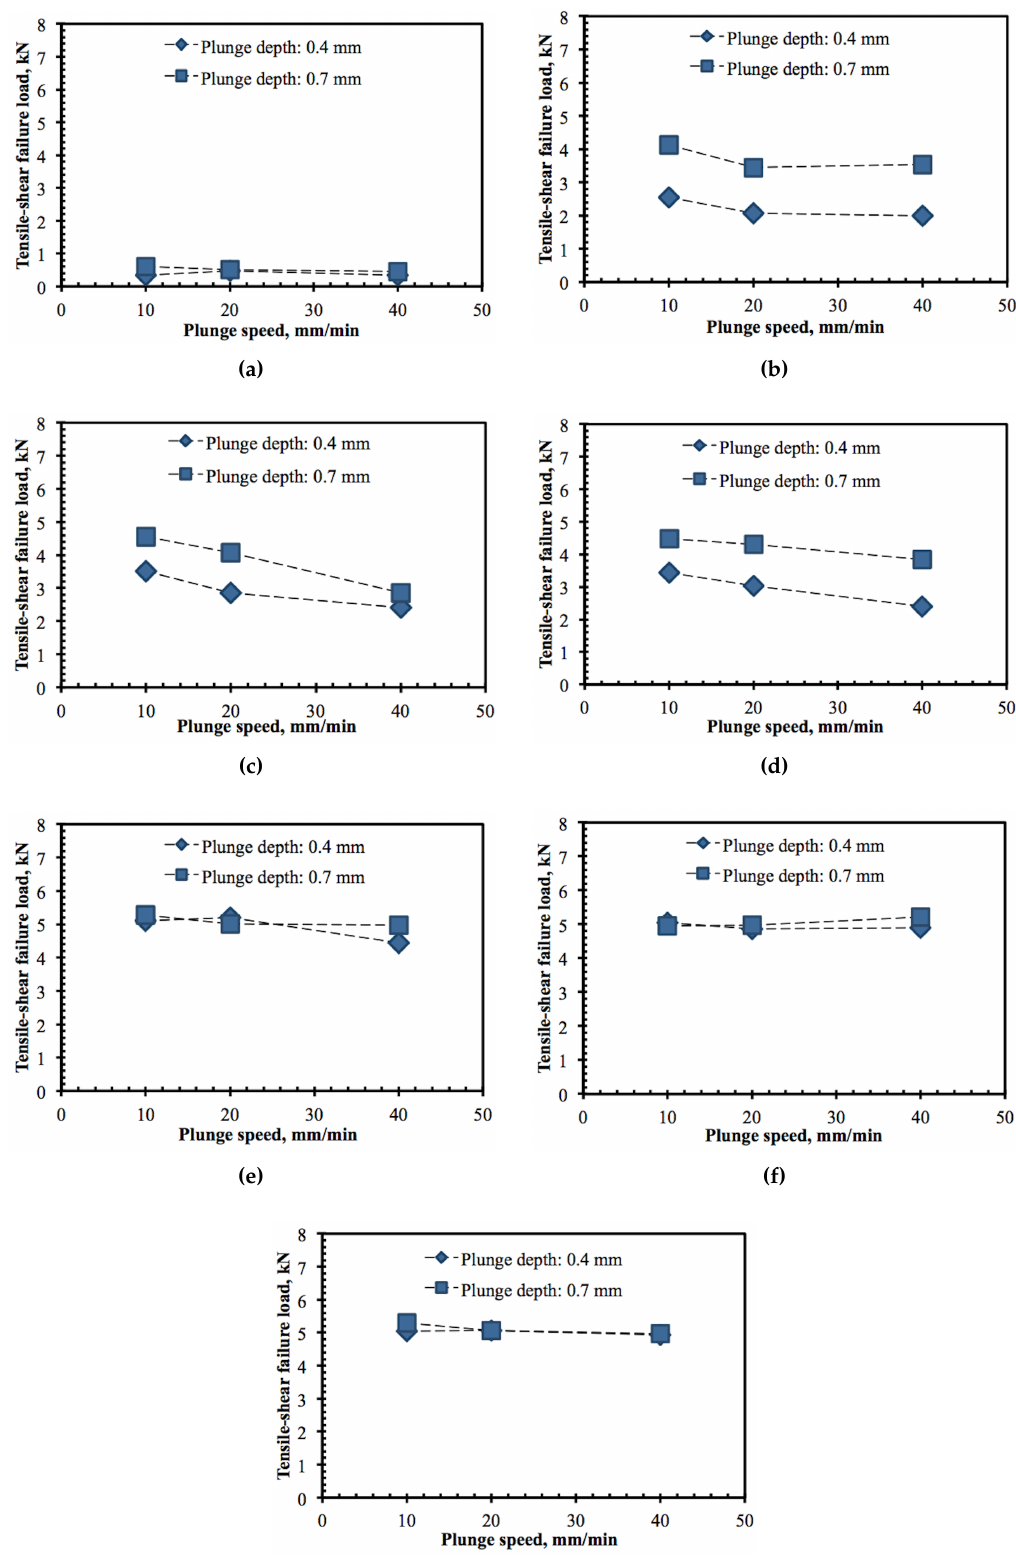
Figure 3. Effect of plunge speed on the tensile-shear failure load for different plunge depth. ( a ) As-received; ( b ) wire brushing; ( c ) etching 30 s; ( d ) etching 1 min; ( e ) etching 2 min; ( f ) etching 6 min; and ( g ) etching 10